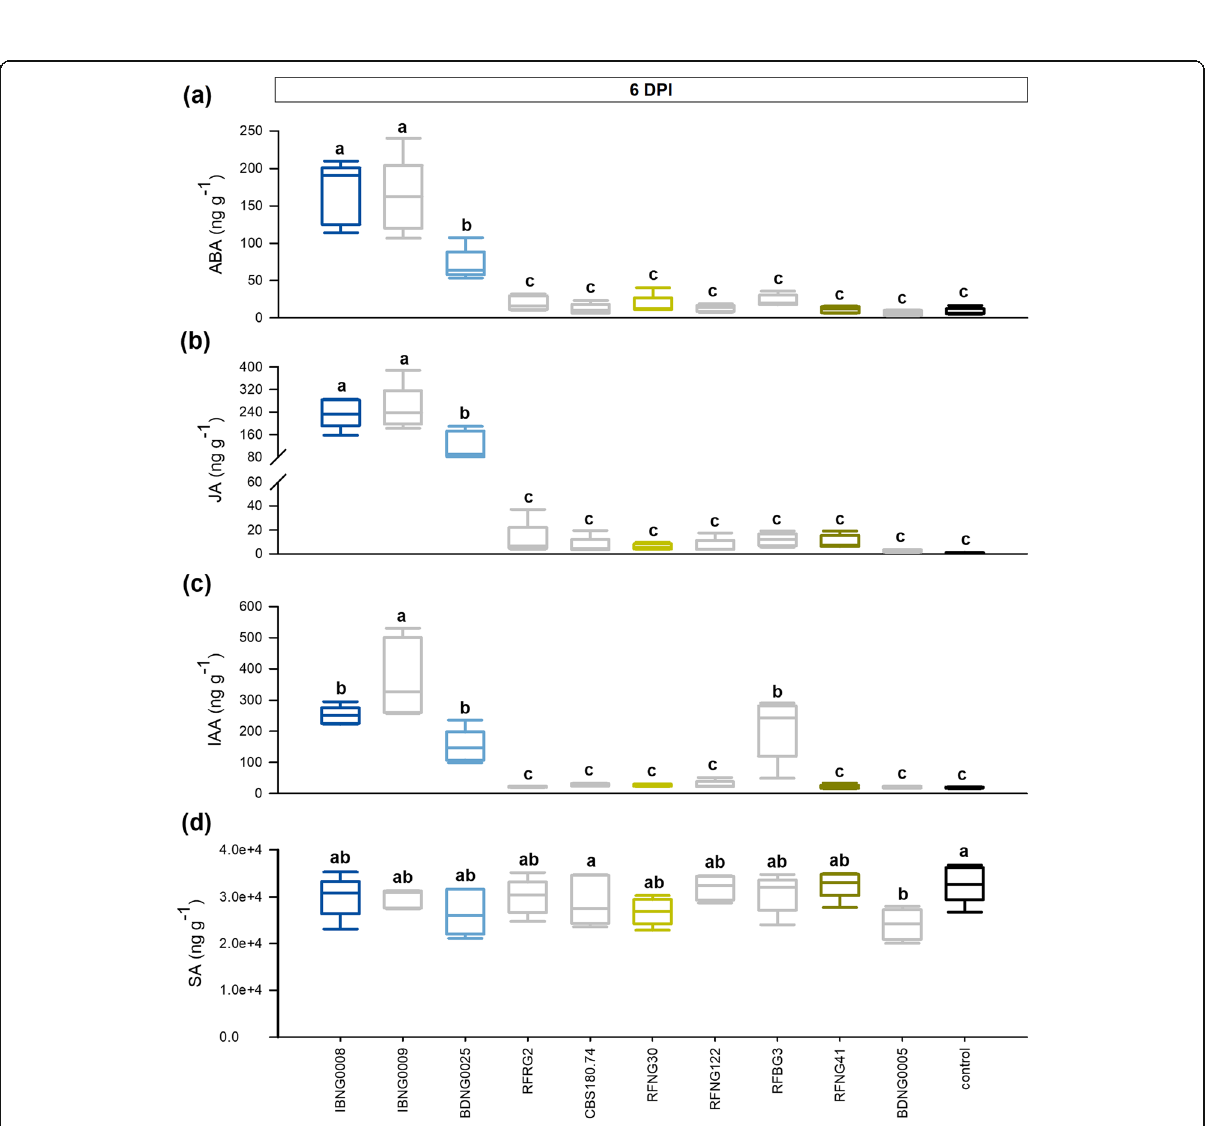
Fig. 3 Phytohormone levels in sheath rot lesion caused by Sarocladium oryzae infection. When 7 weeks old, rice plants were inoculated with various S. oryzae isolates using the standard grain inoculum technique. Sheath samples were collected at 6 days post inoculation (DPI) and the levels of abscisic acid ( a ), jasmonate ( b ), auxin ( c ) and salicylic acid ( d ) were measured. The four S. oryzae isolates that were described above are represented by dark blue (IBNG0008), light blue (BDNG0025), dark green (RFNG41) and light green (RFNG30) boxplots; black boxplots show the results of the healthy control plants. All boxplots represent the median with the first and third quartile, the whiskers show the minimum and maximum values. Boxplots marked with different letters are statistically different (ANOVA, n = 5, α =